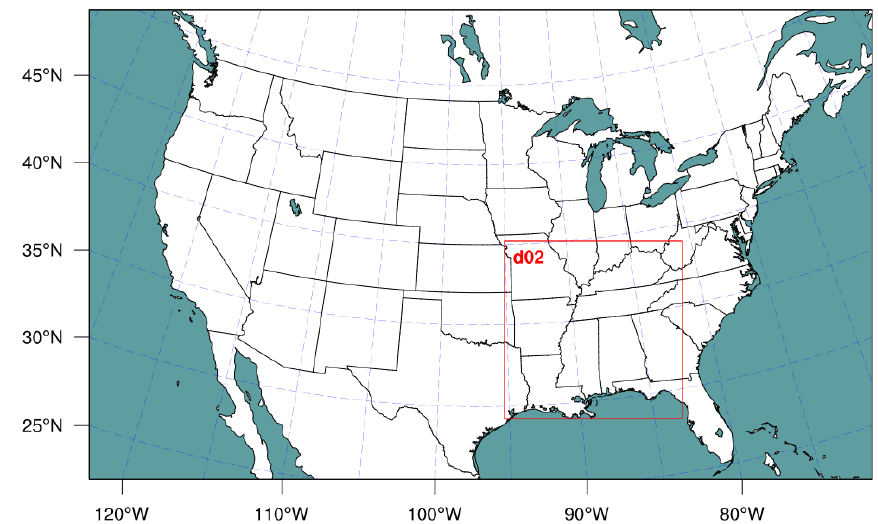
Figure 4. The numerical domains of the NOMADSS simulations: the coarse domain has 442 × 265 grid points with 12km grid cells, and the nested domain, with 4km grid cells, has 301 × 301 grid